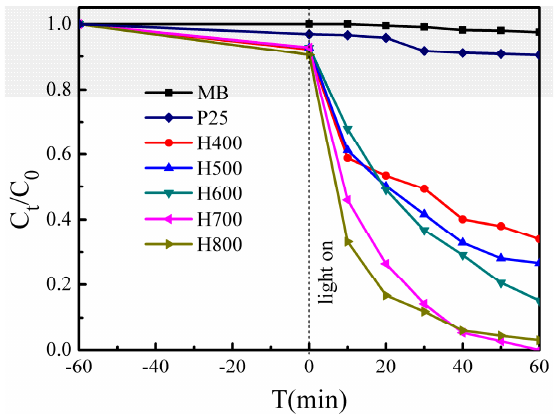
Figure 7. Photocatalytic activity of samples for MB degradation under visible light irradiation.